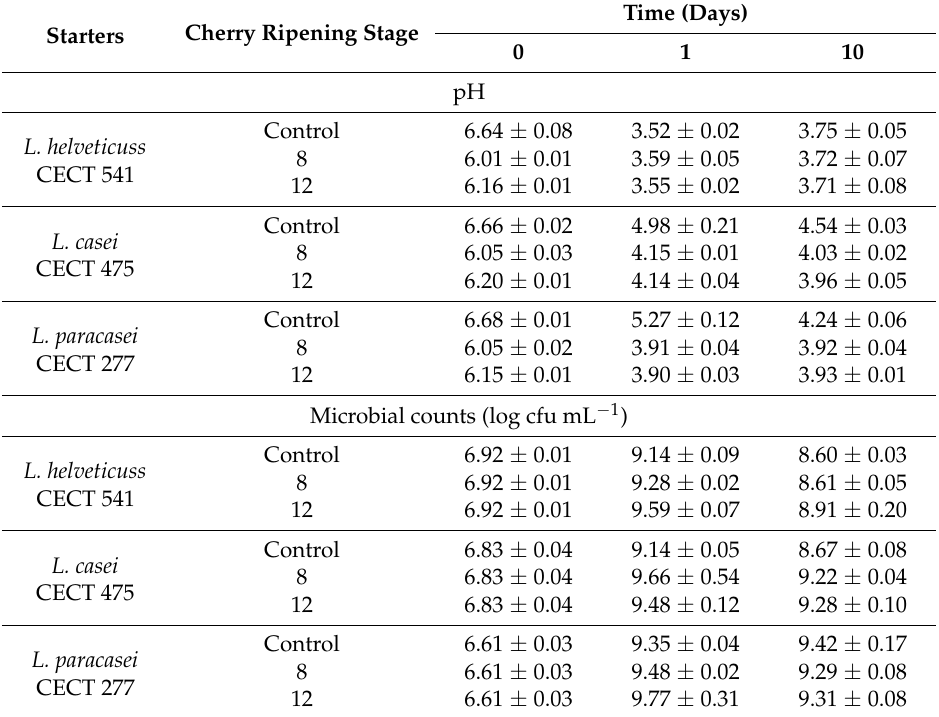
Table 3. pH and microbial counts parameters (average and standard deviation) of fermented milks with sweet cherry puree at different stages of maturation (8 and 12) before fermentation (0) and at days 1 and 10 of refrigerated storage.